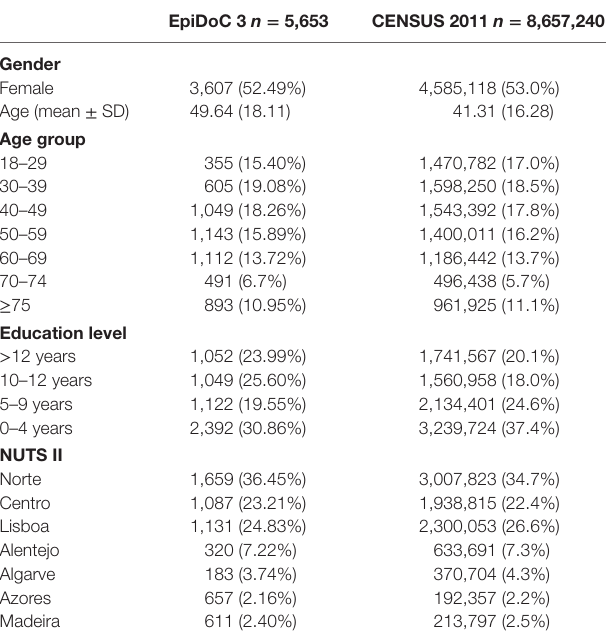
TaBle 1 | Sociodemographic characteristics of the adult Portuguese population: EpiDoC 3 and Census 2011 populations (Portuguese